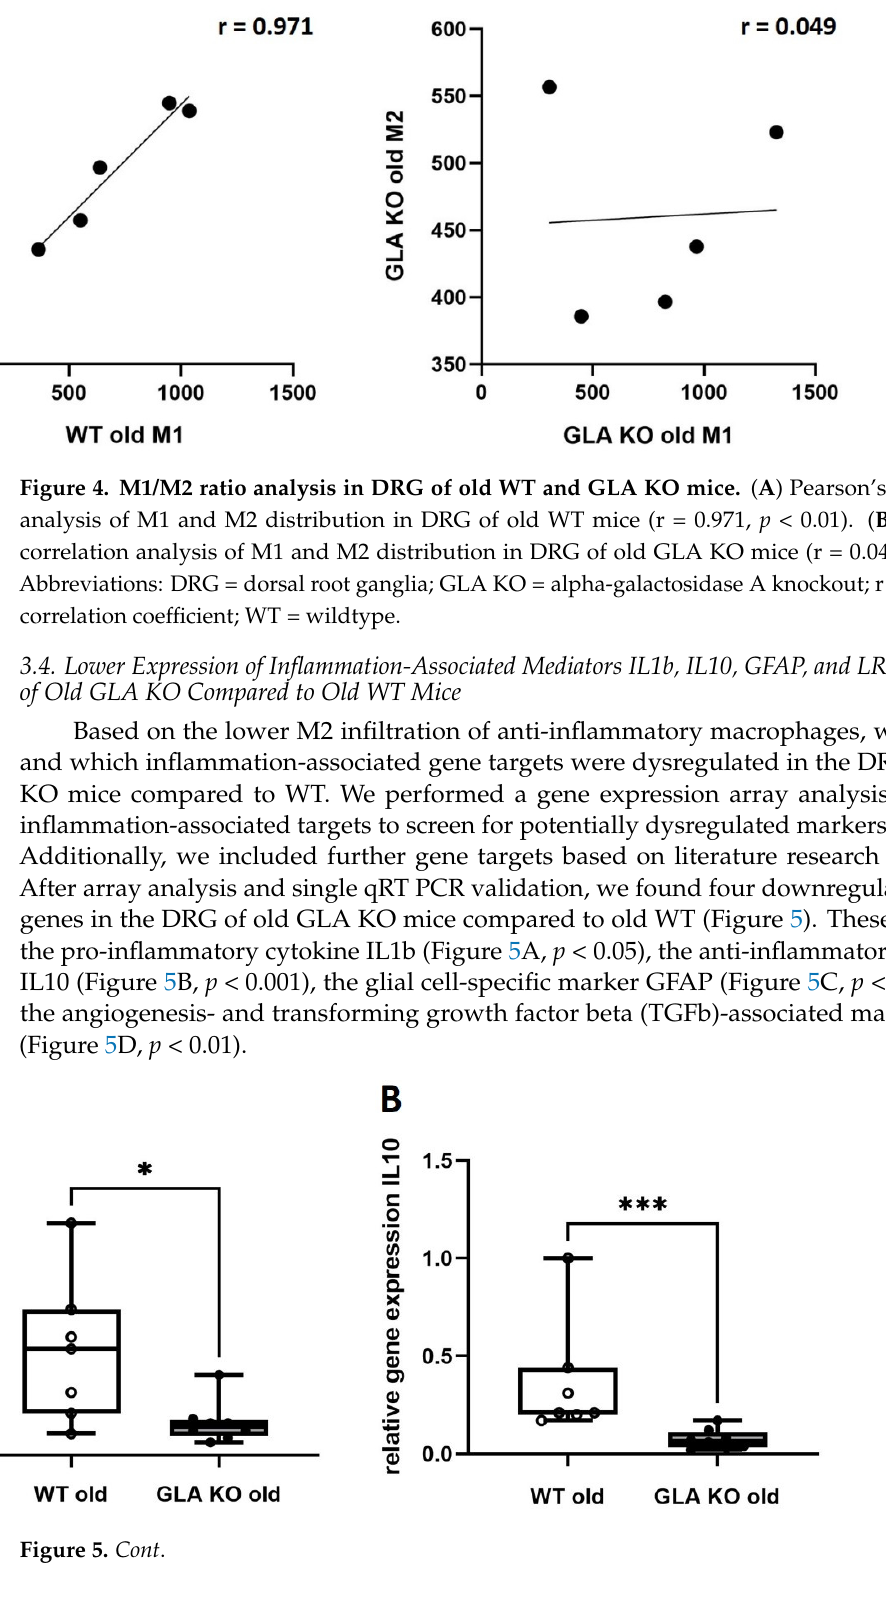
Figure 5. qRT PCR analysis of inflammation-associated targets IL1b, IL10, GFAP, and LRG1. ( A – D ) Relative gene expression of IL1b ( A , WT old n = 7, GLA KO old n = 8), IL10 ( B , WT old n = 7, GLA KO old n = 8), GFAP ( C , WT old n = 6, GLA KO old n = 5), and LRG1 ( D , WT old n = 7, GLA KO old n = 8) in DRG of old WT (  ) and old GLA KO mice (  ). Abbreviations: DRG = dorsal root ganglia; GFAP = glial fibrillary acidic protein; GLA KO = alpha-galactosidase A knockout; IL = interleukin; LRG1 = leucine-rich alpha-2-glycoprotein 1; qRT PCR = quantitative real-time polymerase chain re- action; WT = wildtype. * p < 0.05, ** p < 0.01, *** p < 0.001. 3.5. Lower Ion Channel Gene Expression of KCa3.1 and TRPA1 in DRG of Old GLA KO Compared to Old WT Mice To investigate whether the dysregulated inflammatory targets are associated with the gene expression of selected DRG neuronal pain-associated ion channels, we per- formed qRT PCR analysis for KCa3.1, TRPA1, TRPM8, CaV2.2, and NaV1.8 (Figure 6). We found lower expression of KCa3.1 (Figure 6A, p < 0.001) and TRPA1 (Figure 6B, p < 0.05) in DRG of old GLA KO mice compared to WT littermates, while TRPM8 (Figure 6C, p > 0.05), CaV2.2 (Figure 6D, p > 0.05), and NaV1.8 (Figure 6E, p > 0.05) did not show inter- group differences.